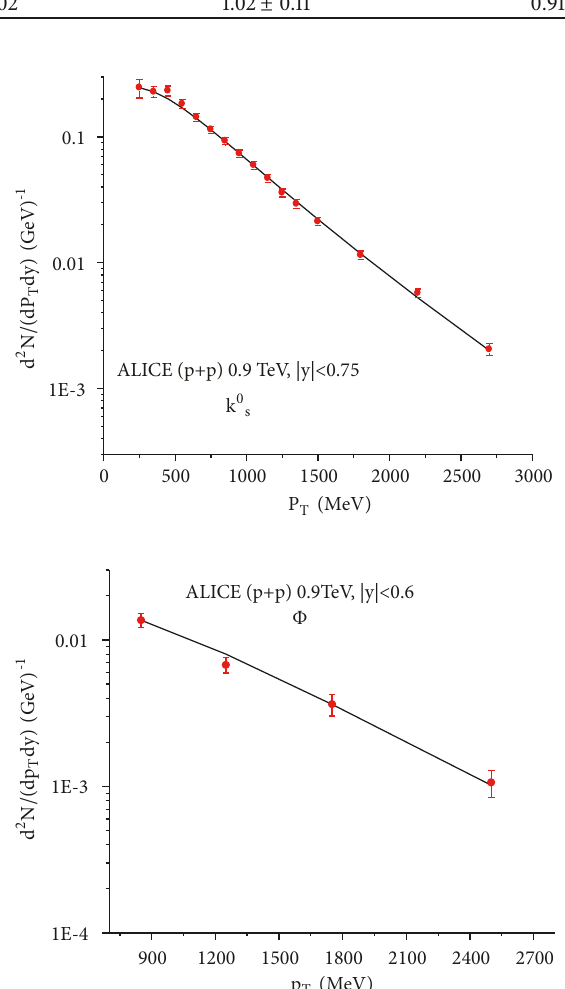
Figure 4: Transverse momentum spectra of 𝐾 0 𝑠 and 𝜙 meson.